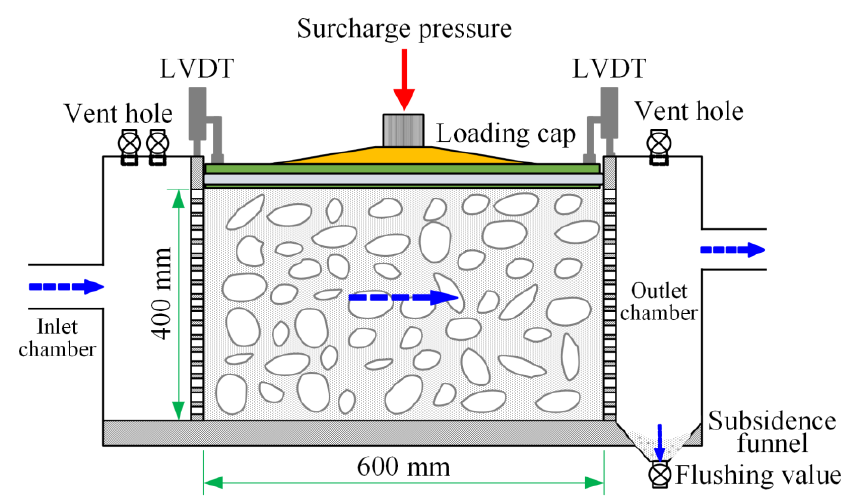
Figure 3. Schematic principle of the erosion apparatus.